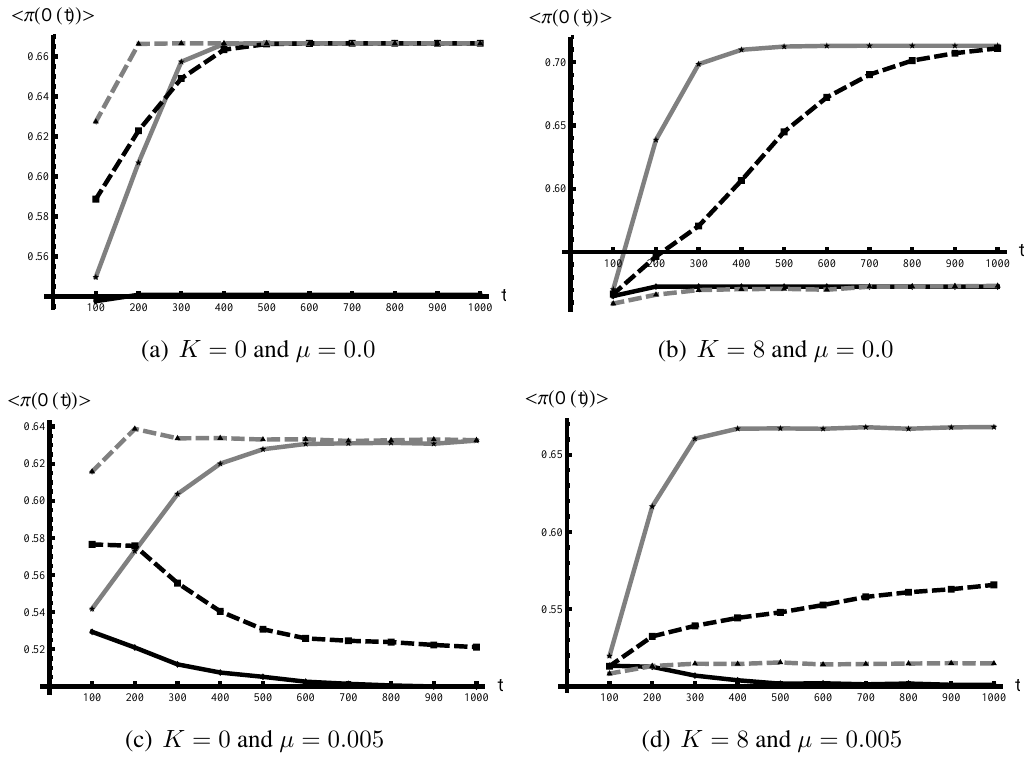
Figure 5. The dynamics of the average value of organizational knowledge for two levels of task complexity, K = 0 ( left ) and K = 8 ( right ), and two degrees of environmental turbulence, µ = 0 . 0 ( top ) and µ = 0 . 005 ( bottom ). Four values of λ are considered: λ = 0 . 0 (solid black), λ = 0 . 2 (solid gray), λ = 0 . 6 (dashed black), λ = 1 . 0 (dashed gray). The communication is active ( p = 1 . 0 ). The data is generated by taking the average per-period value of organizational knowledge for each block of 100 periods. The average from 500 simulation runs is